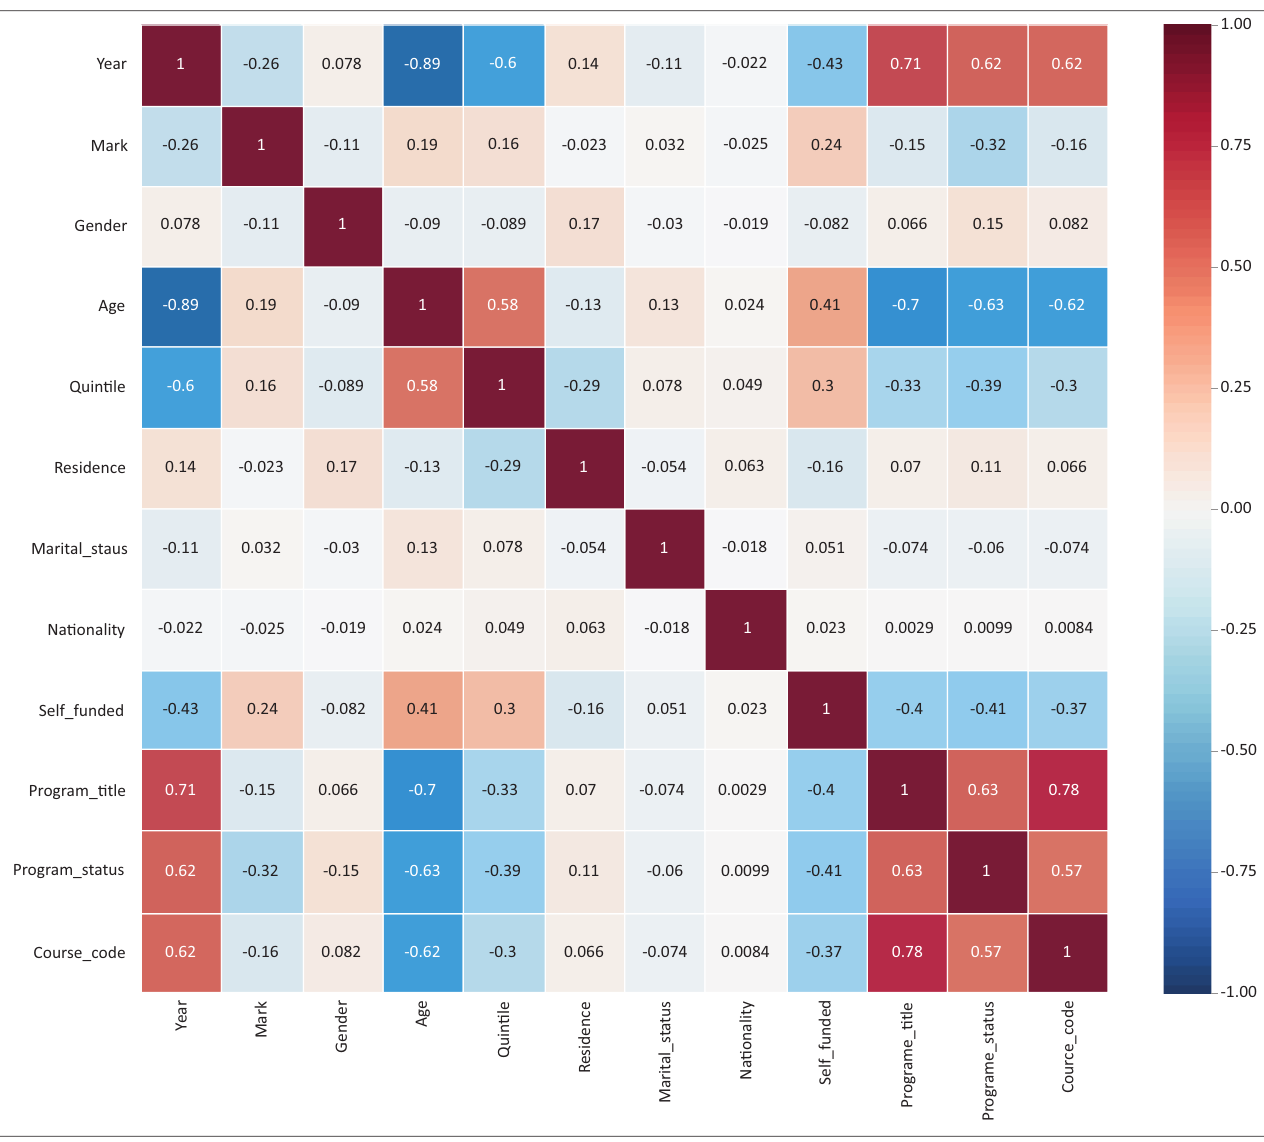
FIGURE 4: Correlation matrix indicating relationship between